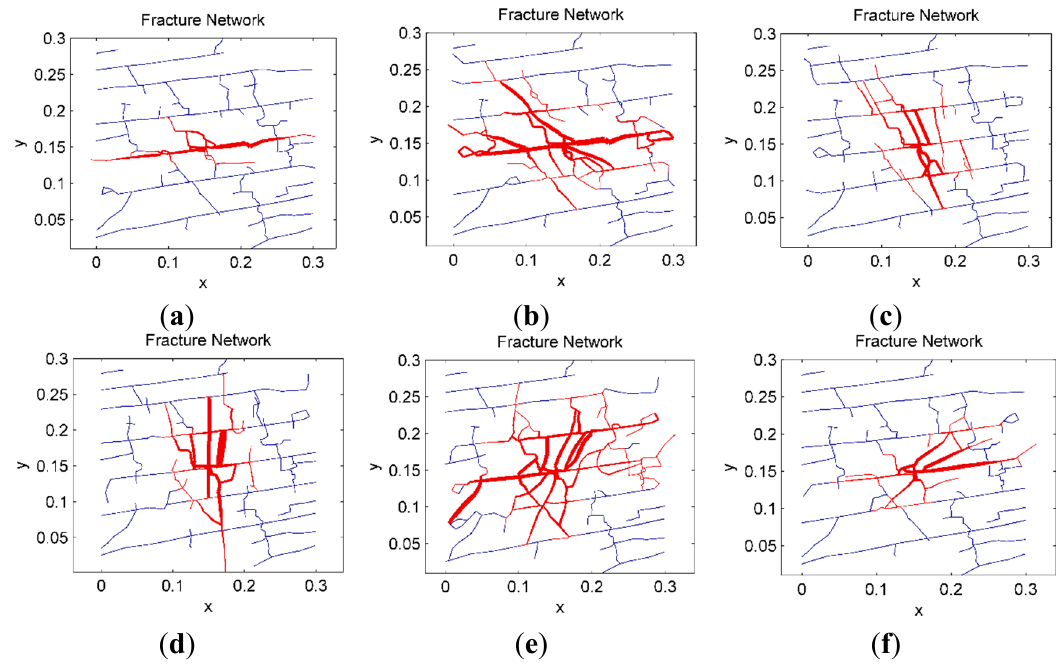
Figure 13. The fracture network configurations. The fractures affected by the fluid injection are colored red and other fractures are colored blue. ( a ) ψ (cid:3404) 0° ; ( b ) ψ (cid:3404) 30° ; ( c ) ψ (cid:3404) 60° ;